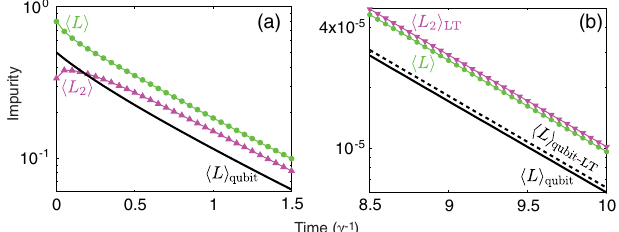
FIG. 18. A comparison of approximations to the evolution of h L i , for D ¼ 3 . (a) h L i , i.e., Eq. (A10), is shown by green circles; i , i.e., Eq. (A16) with the integrals evaluated numerically, is h L 2 , i.e., Eq. (A10), is shown by shown by magenta triangles; h L i qubit i the solid black line. (b) h L , i.e., Eq. (A15), is shown by 2 LT magenta triangles; h L i , i.e., Eq. (A10), is shown by green circles; h L i i.e., Eq. (A17), is shown by the dashed black line; and qubit - LT h L i , i.e., Eq. (A16), is shown by the solid black line. qubit Equation (A13) is not plotted in (b) because, on this scale, it is indistinguishable from h L i